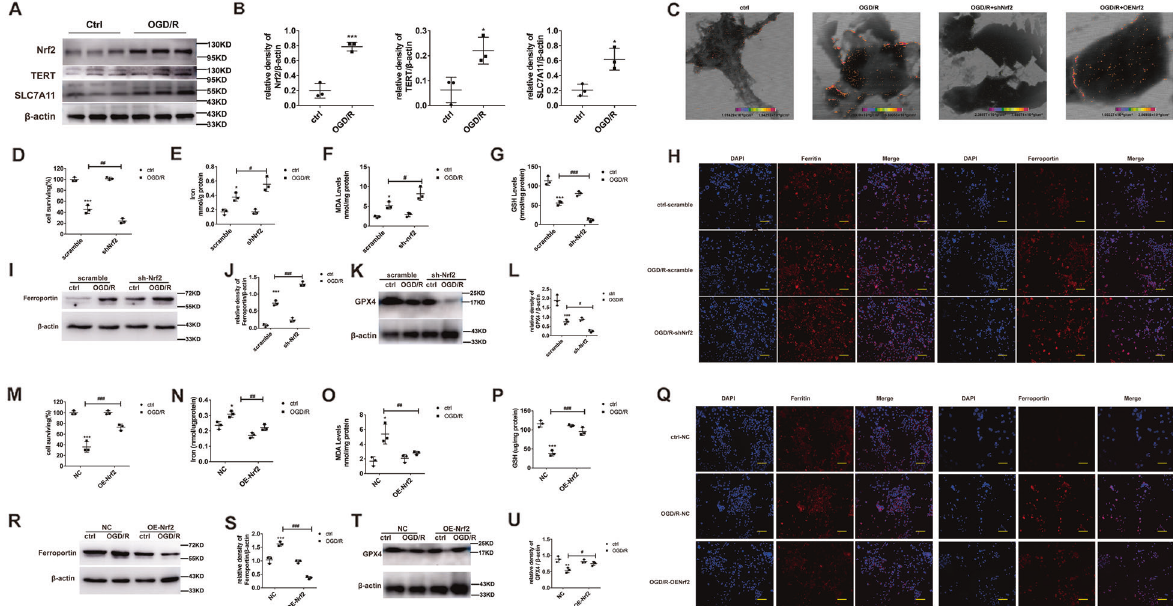
Fig. 4 Nrf2 stimulation prevents ferroptosis and the absence of Nrf2 produces more serious ferroptosis phenotype in OGD/R. A Evaluation of Nrf2 and its potential downstream proteins via western blotting, under different conditions. B Quanti fi cation of the examined proteins. C Fe distribution and content detected via scanning transmission X-ray microscopy. D , M Evaluation of cell viability after OGD/R induction, as evidenced by CCK8 assay. Cells were assigned to three categories: (1) control, (2) OGD/R, and (3) OGD/R + Fer-1 (0.1 μ M). E , N Endogenous Fe levels within pulmonary epithelial cells in the OGD/R model, as detected by Fe assay. F , O MDA levels after OGD/R induction, as assessed by MDA assay. G , P GSH levels after OGD/R induction, as assessed by GSH assay. H , Q Evaluation of ferritin and ferroportin (red), using immunohistochemistry. Nuclear staining done with DAPI (blue) after OGD/R induction. Scale bar: 100 μ m. I – L, R – U Evaluation and quanti fi cation of ferroportin and GPX4 protein levels. Error bars denote standard error from three individual experiments. Data are expressed as mean ± SEM. * P < 0.05, ** P < 0.01, *** P < 0.001 represent intergroup signi fi cant differences. *Relative to the sham control mice. # Relative to the OGD/R